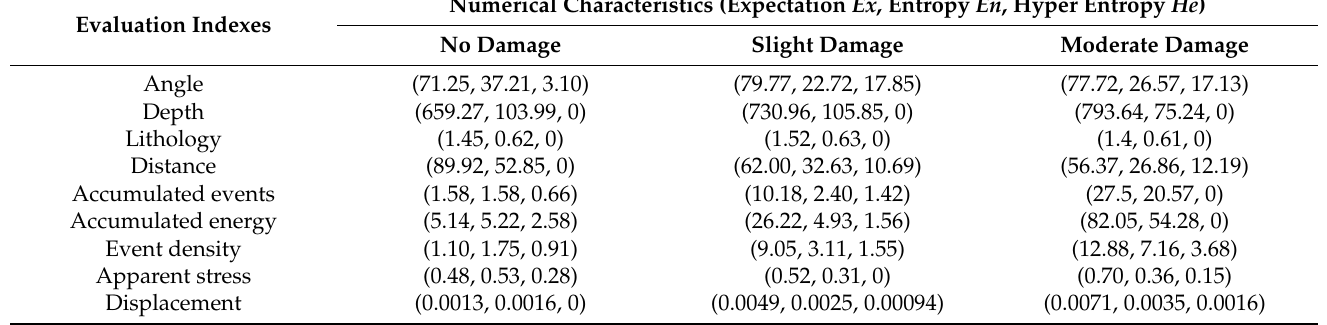
Table 6. Numerical characteristics of the evaluation indexes at different damage levels.